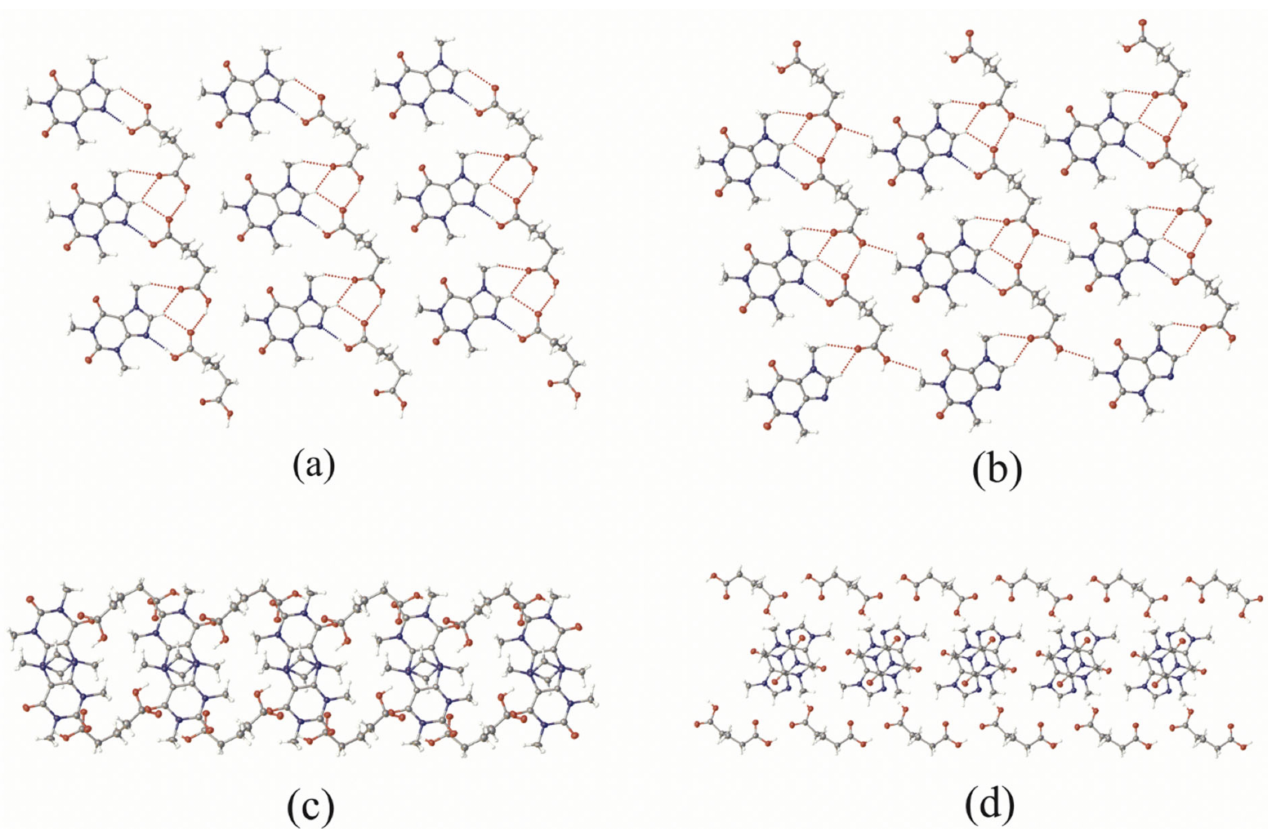
Figure 5. Sheets of caf:glu (1:1) ribbons. ( a ) Form I and ( b ) Form II. Stacked ribbons of caf:glu (1:1): ( c ) Form I and ( d ) Form II. CSD refcodes: Form I; EXUQUJ ( P 2 1 / c ) and Form II; EXUQUJ01